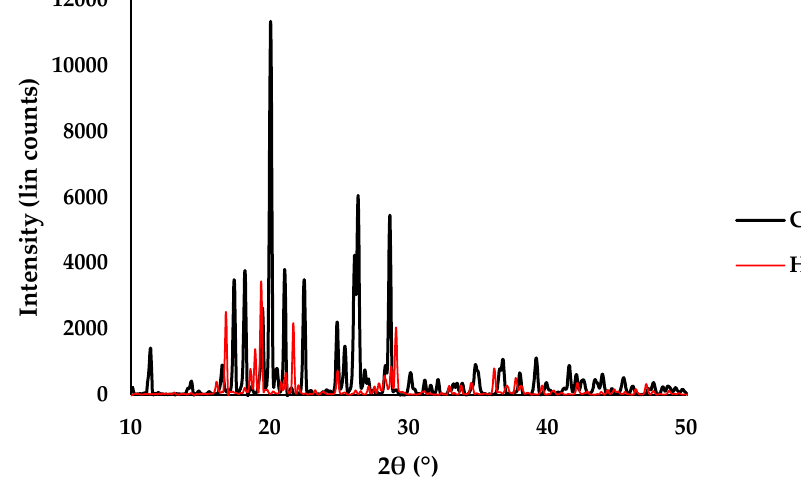
Figure 4. Powder X-ray di ff ractogram for HCTZ (red) and CPT (black).